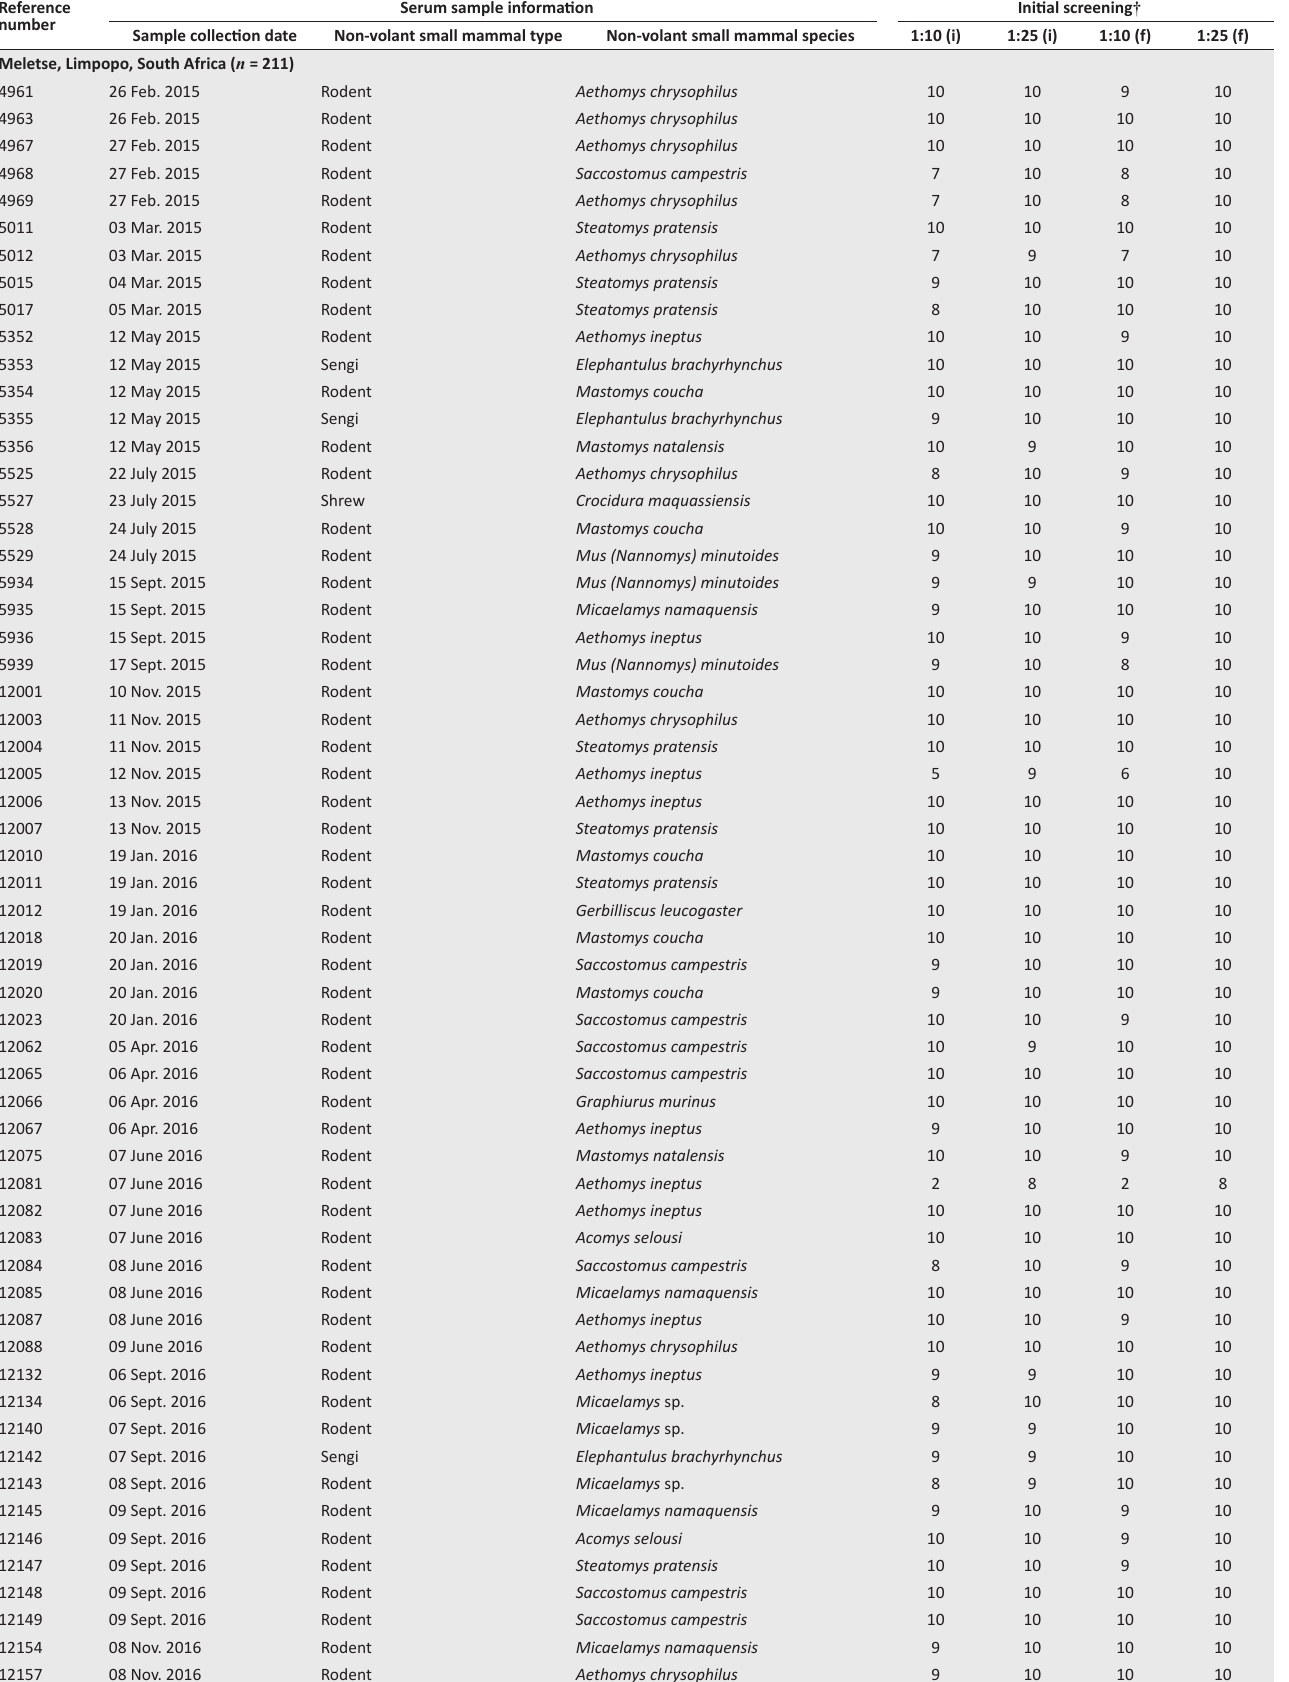
TABLE 4-A1: Micro-neutralisation test results of all non-volant small mammal serum samples that tested negative for the presence of Mokola virus neutralising antibodies. Reference